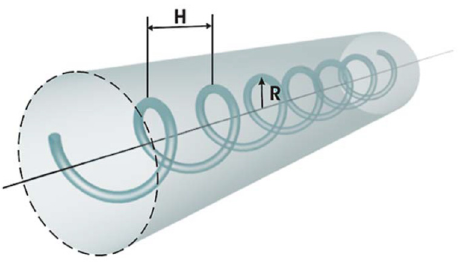
Figure 1. The model for a helical core-based HLPG. Adapted with permission from Ref. [23] © APS.